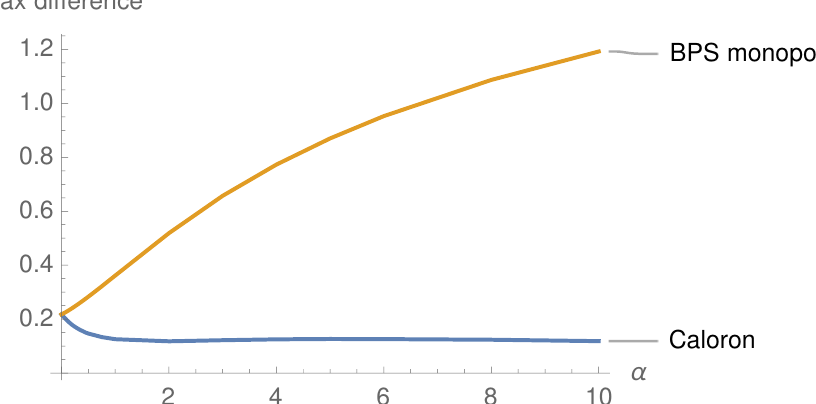
Figure 12. The maximum di(cid:11)erence between the Skyrme (cid:12)eld pro(cid:12)le function for the charge 1 BPS monopole, and optimum Harrington-Shepard caloron, as a comparison with the ordinary spherically-symmetric